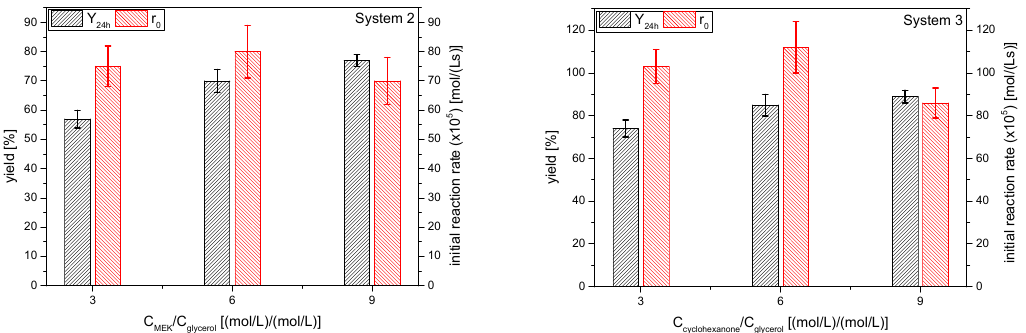
Figure 14. Influence of the ketone excess on the yield of ketals 2 and 3 at 24 h and the initial reaction rate (Reaction conditions: butanone / glycerol or cyclohexanone:glycerol molar ratio, 6:1; temperature, 40 °C).